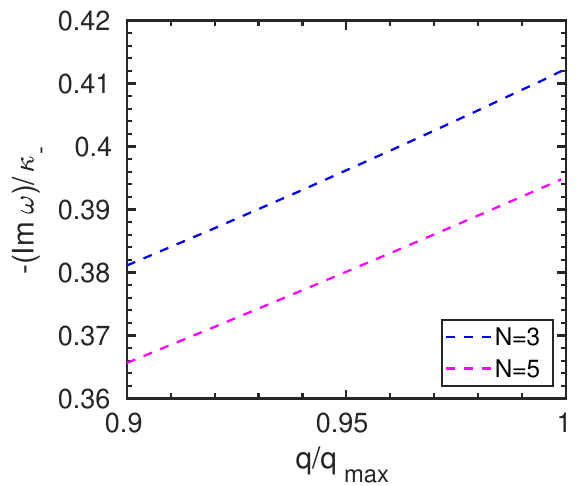
Figure 4 . The ratio − ( Im ω/κ − ) has been plotted against ( q/q max ) , where we have taken the value of the cosmological constant to be Λ = − 0 . 06 and the black hole mass M = 1 , for two different choices of the Lovelock order N